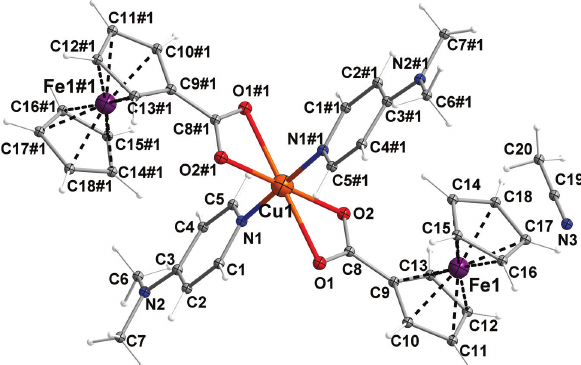
Table 1: Data collection and